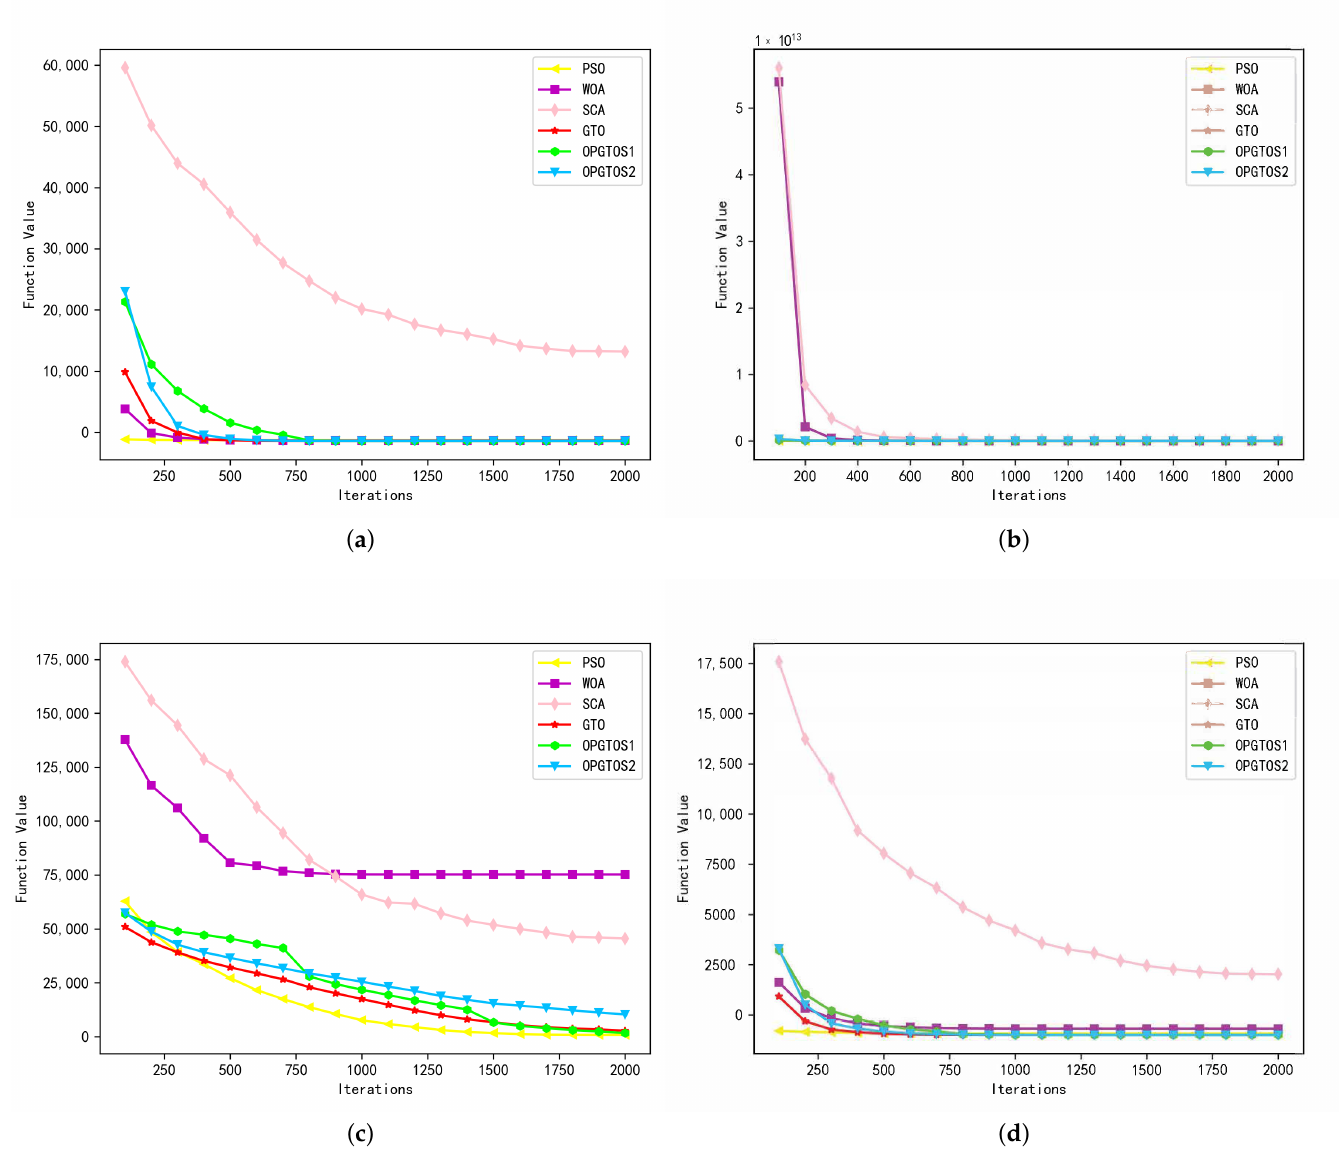
Figure 6. Simulation results of unimodal functions in 30 dimensions. ( a ) F1. ( b ) F3. ( c ) F4. ( d )